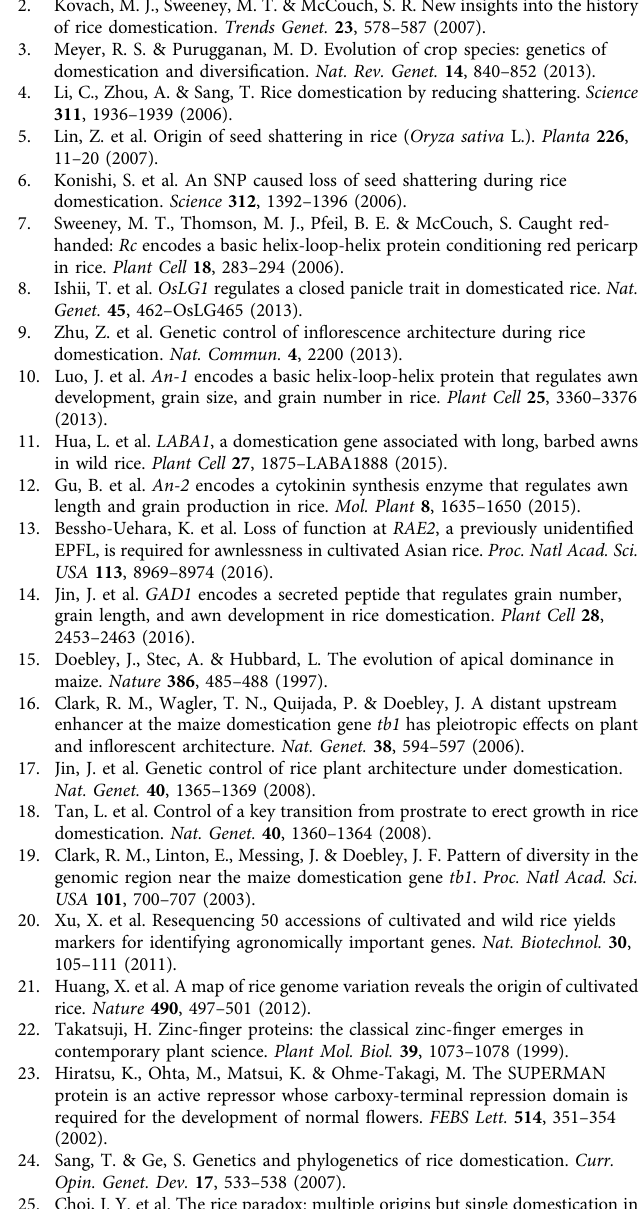
Table 2). To investigate the function of ZnF8 YJCWR from YJCWR (the allele of ZnF8 in DXCWR), the 3487-bp fragment harboring the entire ZnF8